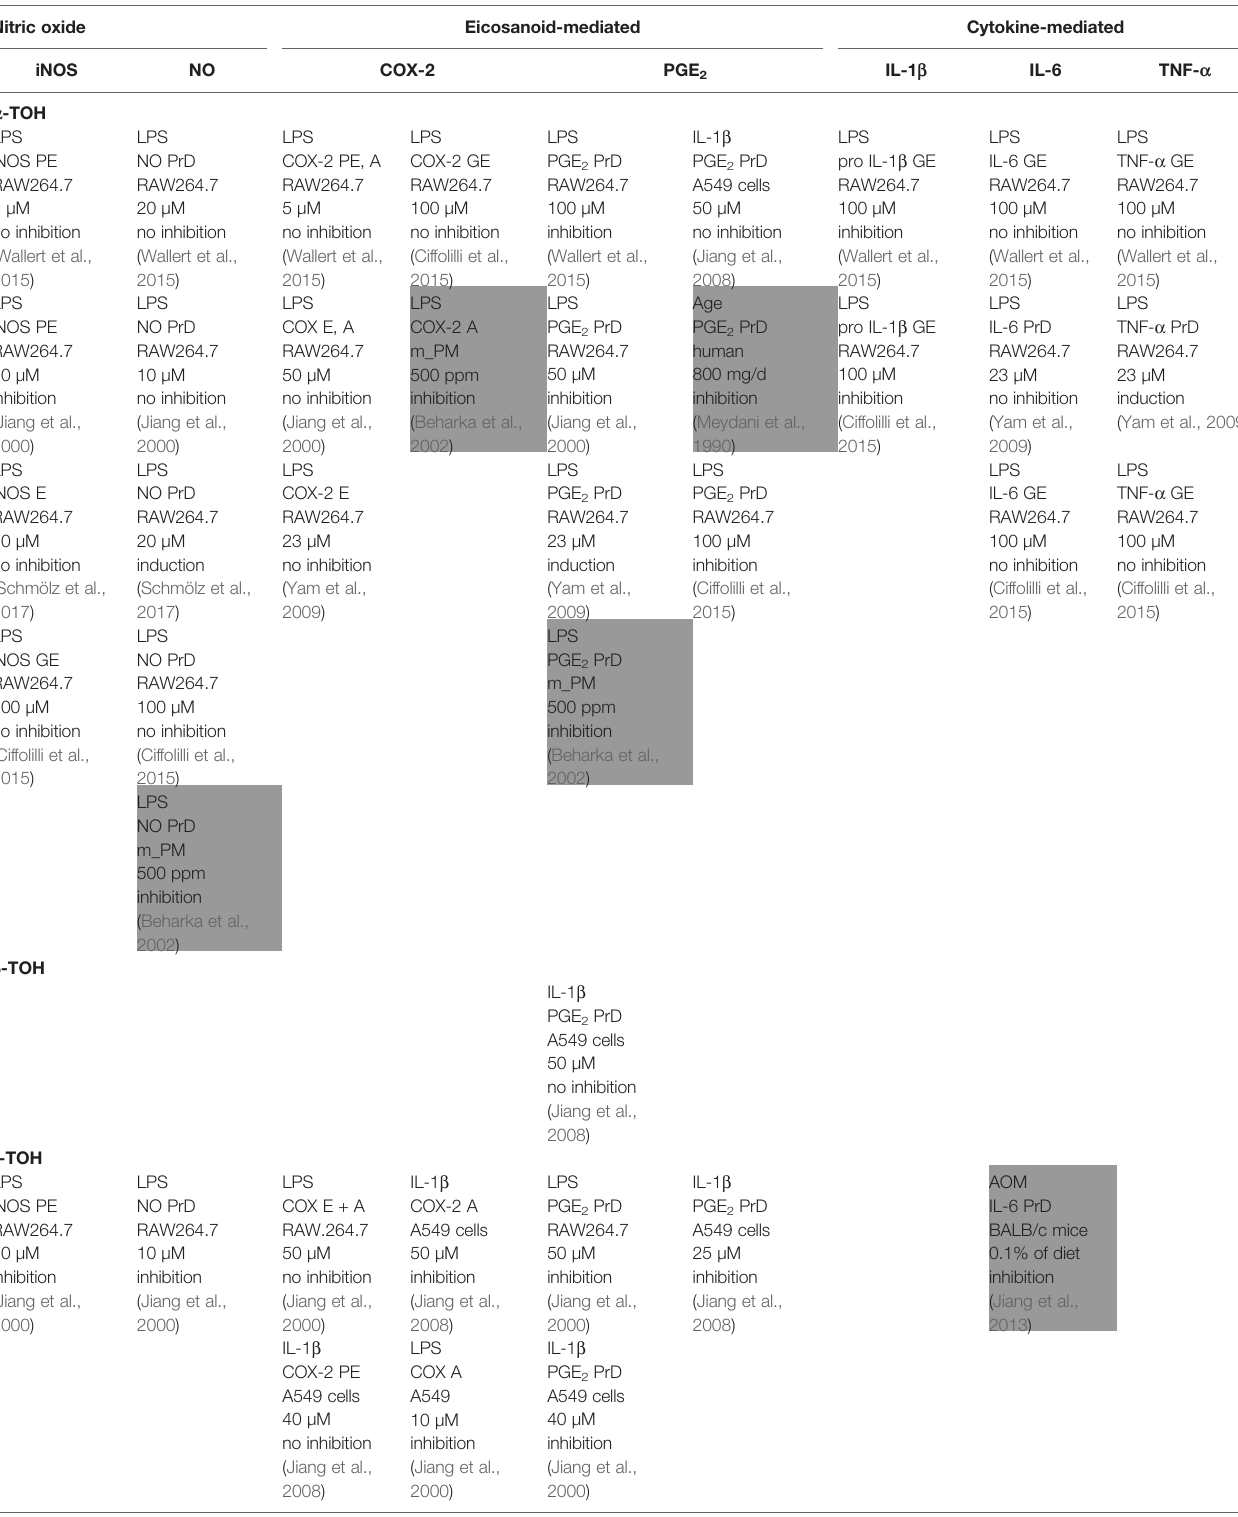
TABLE 1 | Overview on the biological activities of chromanols linked to in fl ammation. Nitric